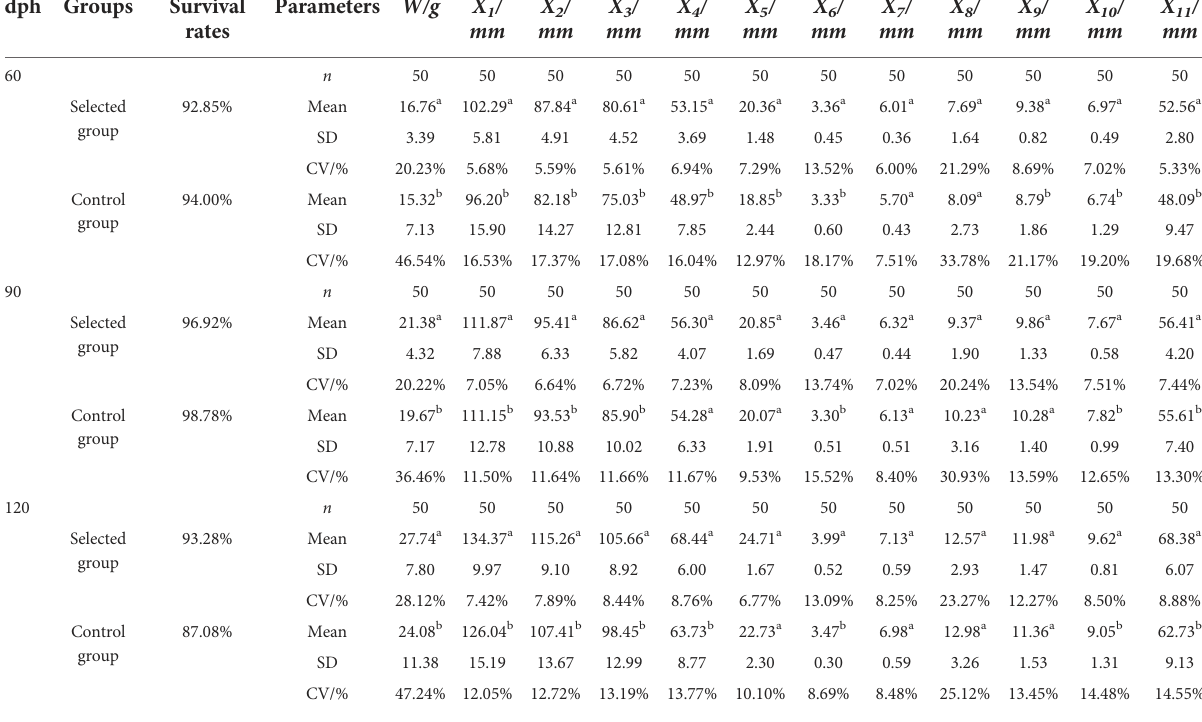
TABLE 3 Descriptive statistics of various morphological traits of P. argenteus from the selected group and control group at 60, 90, and 120 days post-hatching (dph). dph